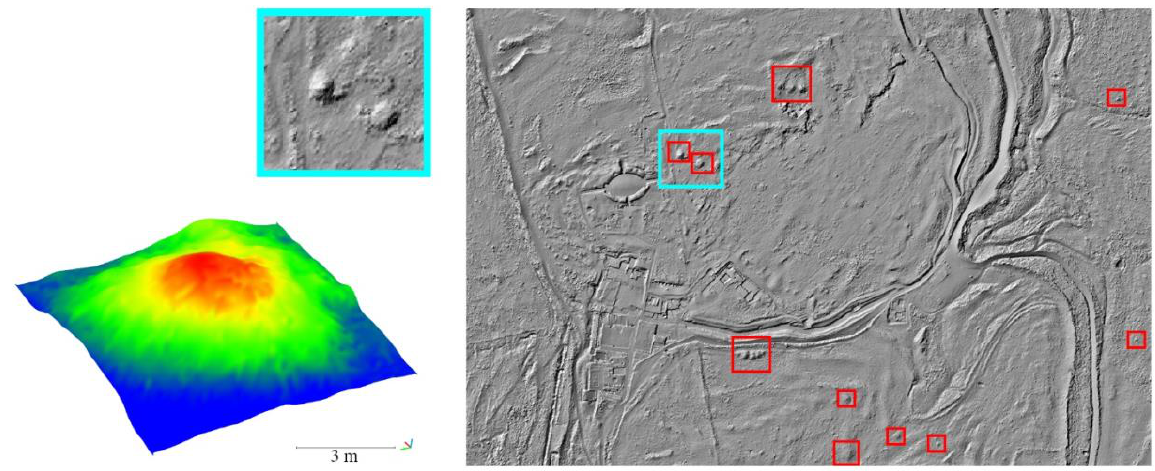
Figure 9. On the left, the 3D point cloud of a not excavated mound. On the right, the raster DTM, visualised with a combination of hillshaded terrain , slope , openness , and sky view factor to highlight the not excavated mounds (in red